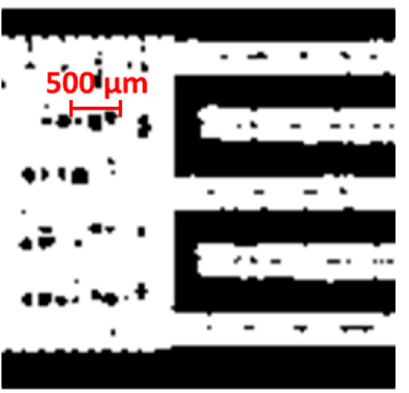
Figure 4. Detail of a binarized image of a sample including internal holes, which are the black spots in the white comb shapes ( Δ x = 140 mm, Δ y = 170 mm, v p = 10 mm/s, T n = 35